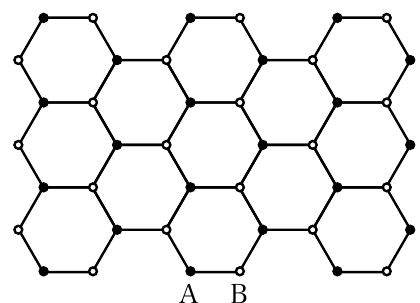
Figure 1 . The bipartite honeycomb lattice has two kinds of sub-lattices A and B. that the honeycomb lattice system corresponds to an unconventional moduli identi(cid:12)cation while the triangular lattice to a more natural